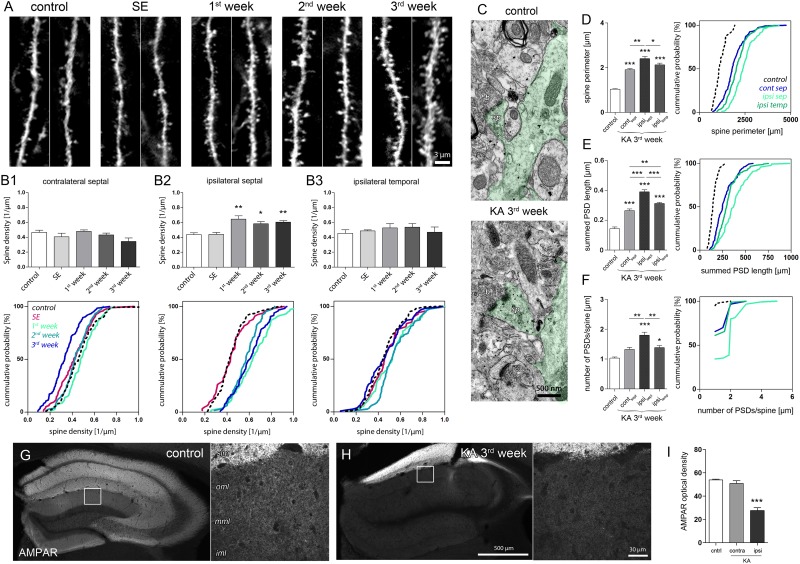
Structural and molecular site plasticity of excitatory postsynaptic contacts on DGCs. (A) Representative confocal images of individual eGFP-labeled DGC dendritic segments located in the middle or outer molecular layer of the ipsilateral septal hippocampus. Two dendritic segments are shown for each time point. (B1–B3) Quantitative analysis of DGC spine density changes during epileptogensis. Number of mice: ncntrl = 5, nSE = 3, n1w = 4, n2w = 3, n3w = 5. One-way ANOVA, Newman–Keul’s post-test. ∗P < 0.05, ∗∗P < 0.01, ∗∗∗P < 0.001. Corresponding cumulative probability plots are shown below. (C) Representative electron microscopy images of an eGFP-labeled dendrite (green shading) in the middle molecular layer. sp, spine; b, bouton. (D–F) Quantitative analysis of ultrastructural spine features (perimeter; summed length of PSD, number of PSDs per spine) in controls and chronically epileptic mice. Ultrastructural features are compared between different hippocampal locations (contralateral septal: ncontra-sept = 5; ipsilateral septal: nipsi-sept = 6, ipsilateral temporal: nipsi-temp = 6) and control hippocampi (ipsilateral septal: ncntrl = 3). One-way ANOVA, Newman–Keul’s post-test. ∗P < 0.05, ∗∗P < 0.01, ∗∗∗P < 0.001. Corresponding cumulative probability plots are shown at the right. (G,H) Representative images of AMPAR immunoreactivity in the control and chronically epileptic hippocampus, respectively. Left panel, overview; right panel, high-magnification confocal image. iml, inner molecular layer; mml, middle molecular layer; oml, outer molecular layer; slm, stratum lacunosum moleculare. (I) Quantitative analysis of AMPAR optical density in the molecular layer. Number of mice: ncntrl = 4; nKA,contra = 4, nKA,ipsi = 4. One-way ANOVA, Newman–Keul’s post-test. ∗P < 0.05, ∗∗P < 0.01, ∗∗∗P < 0.001.